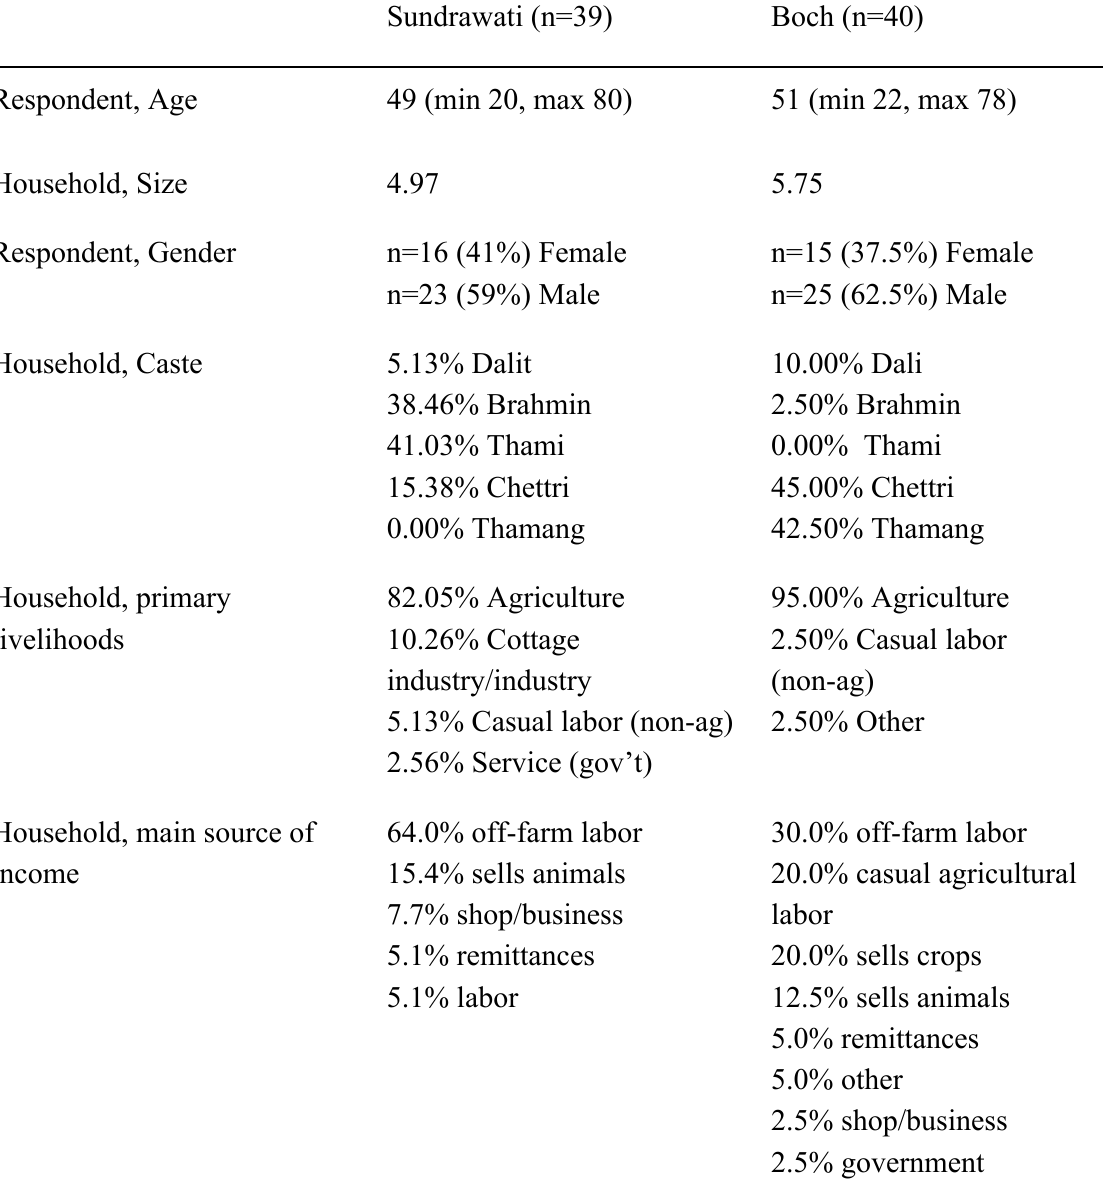
Table A.1. Summary of demographic and socio-economic characteristics of study sites collected ​ ​ through survey